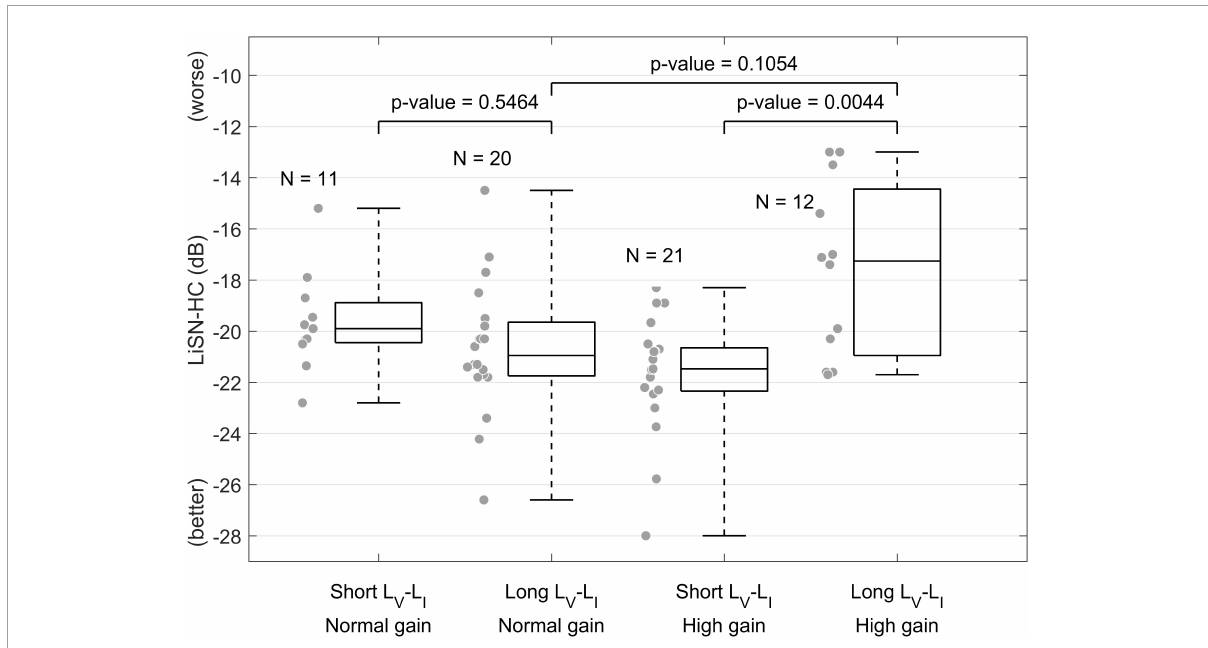
FIGURE4 Effect of elevated central gain and brainstem neural transmission time on speech-in-noise intelligibility (Valderrama et al., 2018). This figure shows that when central gain at the level of the midbrain is elevated (high gain), individuals with longer brainstem neural transmission time (measured via the ABR waves I-V interpeak latency) presented worse speech-in-noise hearing